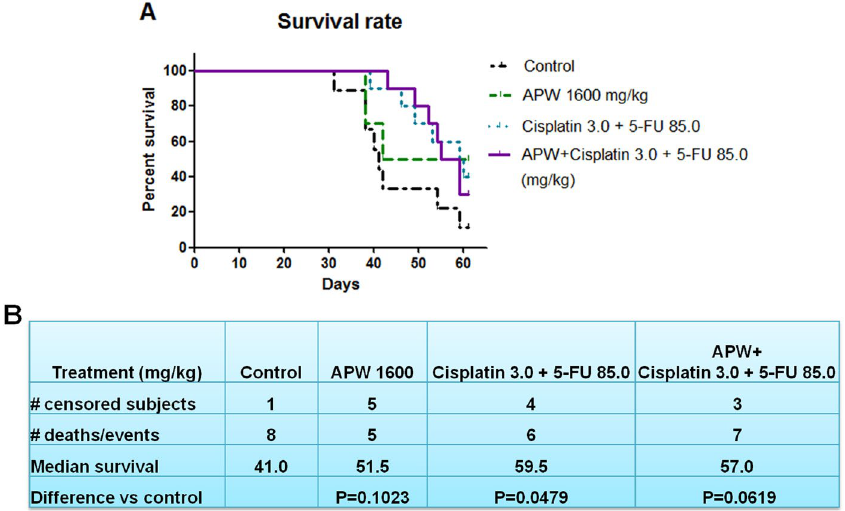
Figure 5. Treatments with APW alone, the combination of cisplatin and 5-FU and the combination of APW, cisplatin and 5-FU resulted in prolonged survival in mice inoculated with EC-109 cells intraperitoneally. Differences among treatment groups were compared using the LogRank test (n =